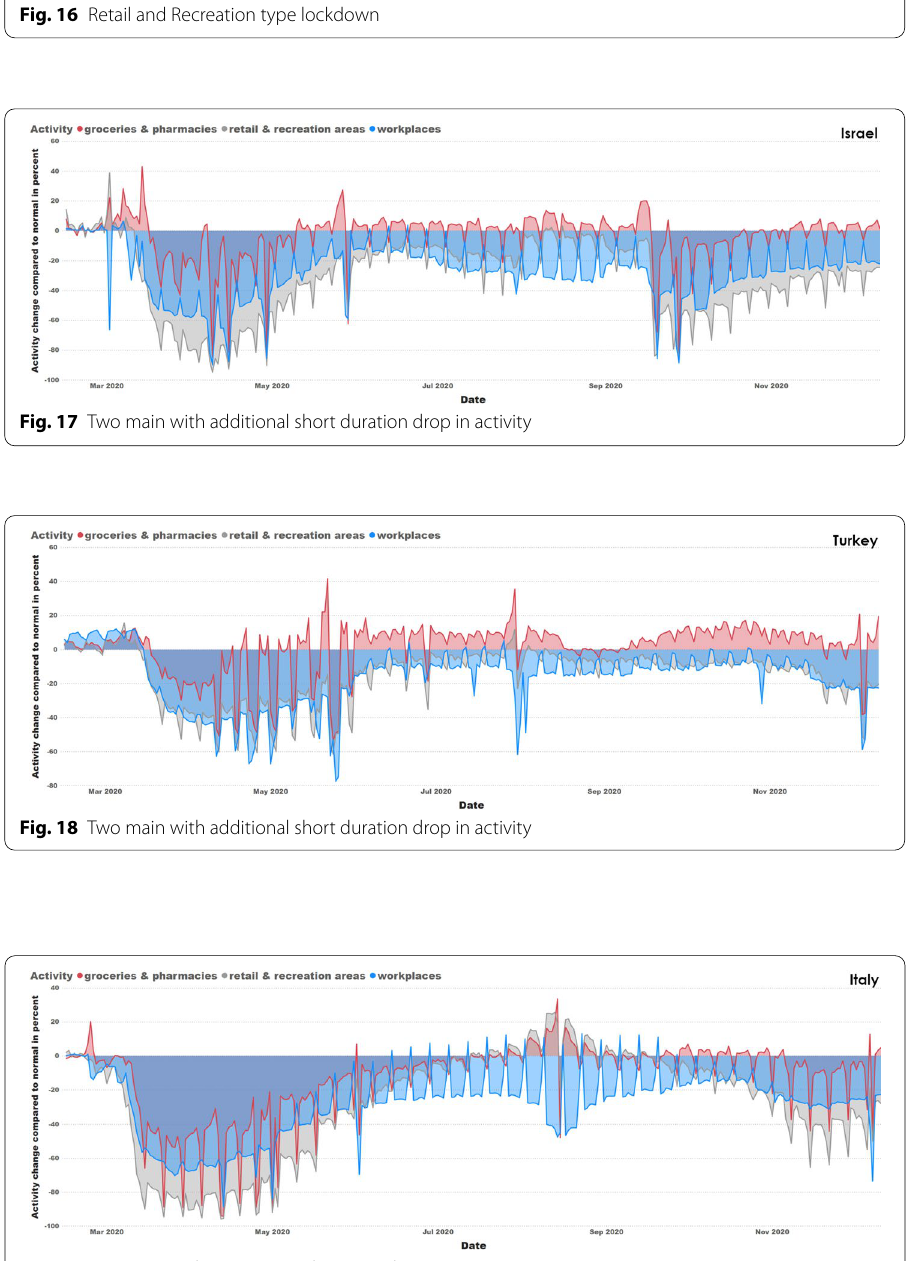
Fig. 19 Two main with summer work activity